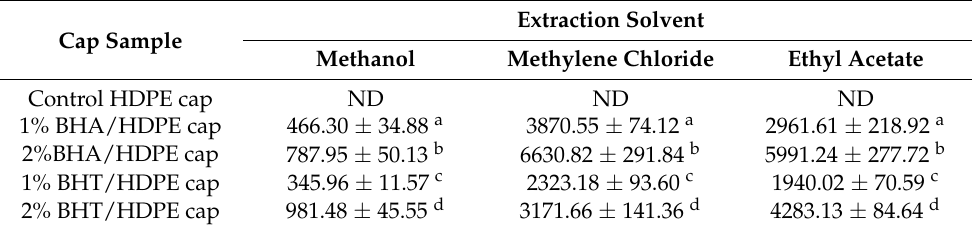
Table 9. BHA or BHT extraction from antioxidant active caps by different solvents (mg/kg, mean ± SD, n =